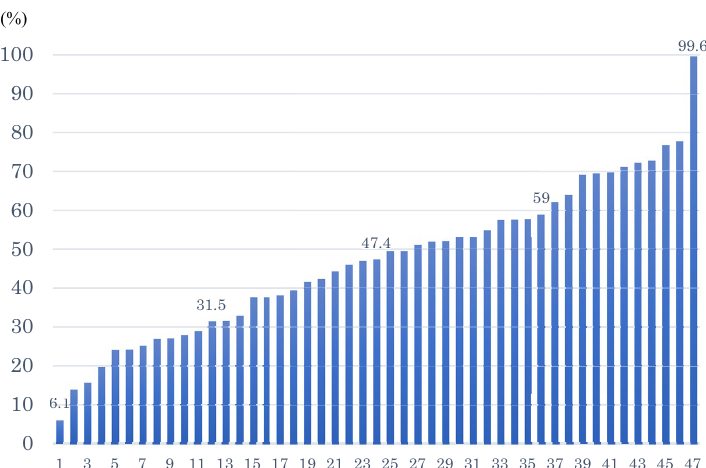
Figure 2. The frequency of pre-hospital advanced airway management approach for cardiac arrest cases in the